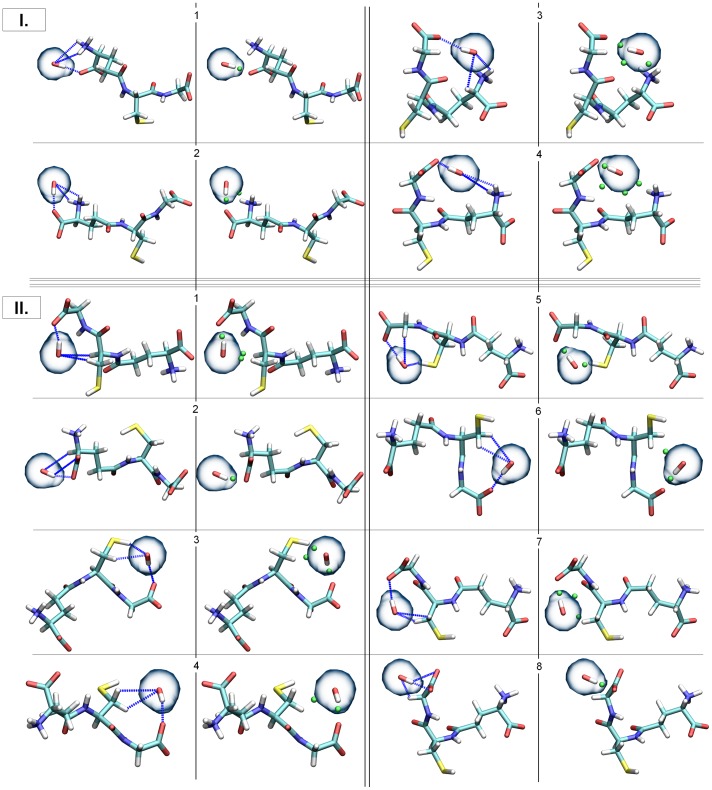
The structures that contained the maximum (3) number of interactions between GSH and the OH• based on the geometrical criteria are depicted (I. – zwitterionic group, II. – anionic group).The interactions based on geometrical criteria are indicated with blue, dashed lines, while those resulted from the AIM analyses are depicted with green points (bond critical points, BCPs).